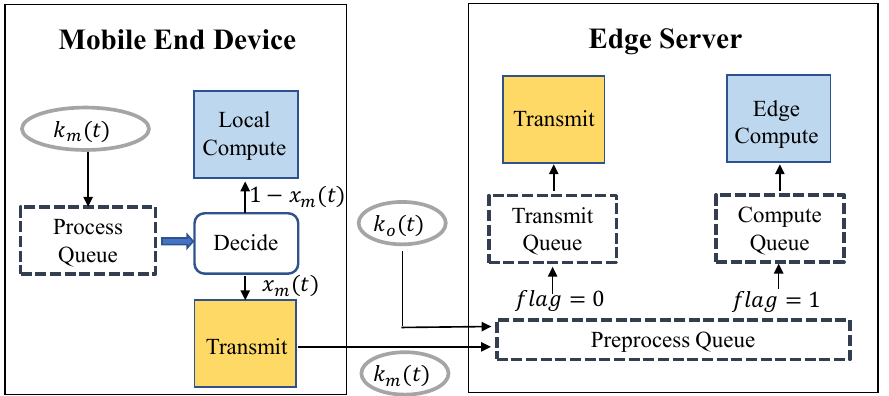
Figure 2. An illustration of task-processing